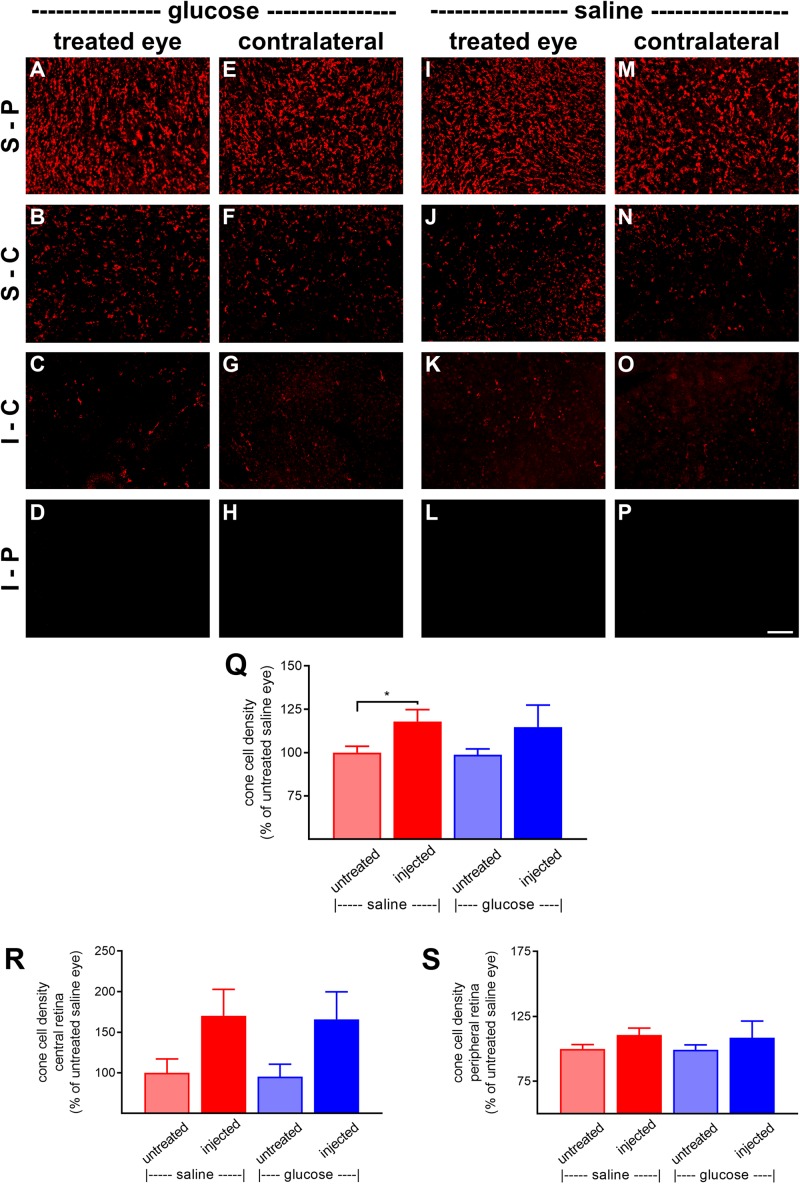
Effect of daily glucose injections on M/L-opsin+-cone survival. (A–P) Photomicrographs of wholemount Rd1 retinas analyzed at postnatal day (P) 60 immunolabeled for M/L-opsin. Representative images from glucose-injected eyes (A–D) and the respective contralateral untreated eyes (E–H), saline-injected eyes (I–L) and the respective contralateral untreated eyes (M–P) are shown. S-P, superior-peripheral retina; S-C, superior-central retina; I-C, inferior-central retina; I-P, inferior-peripheral retina. Scale bar 100 μm. (Q–S) Quantification of S-opsin-labeled cones in retinal wholemounts from Rd1 mice treated with daily unilateral subconjunctival injections of glucose or saline, and in the respective untreated contralateral eyes. Data are shown for the whole retina (Q), subdivided into central (R), and peripheral (S) regions. Values, shown as % of the untreated saline group, represent mean ± SEM, where n = 11–13. ∗P < 0.05 by Student’s paired t-test (saline-injected vs. untreated contralateral eyes). There were no significant differences between glucose-injected and untreated contralateral eyes (Student’s paired t-test) or between saline-injected eyes and glucose-injected eyes (Student’s unpaired t-test).